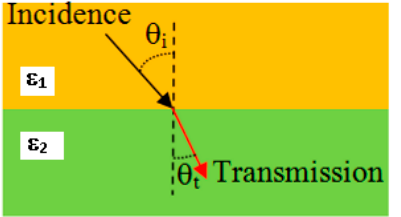
Figure 2. Refraction of wave by Snell—Descartes’s law.